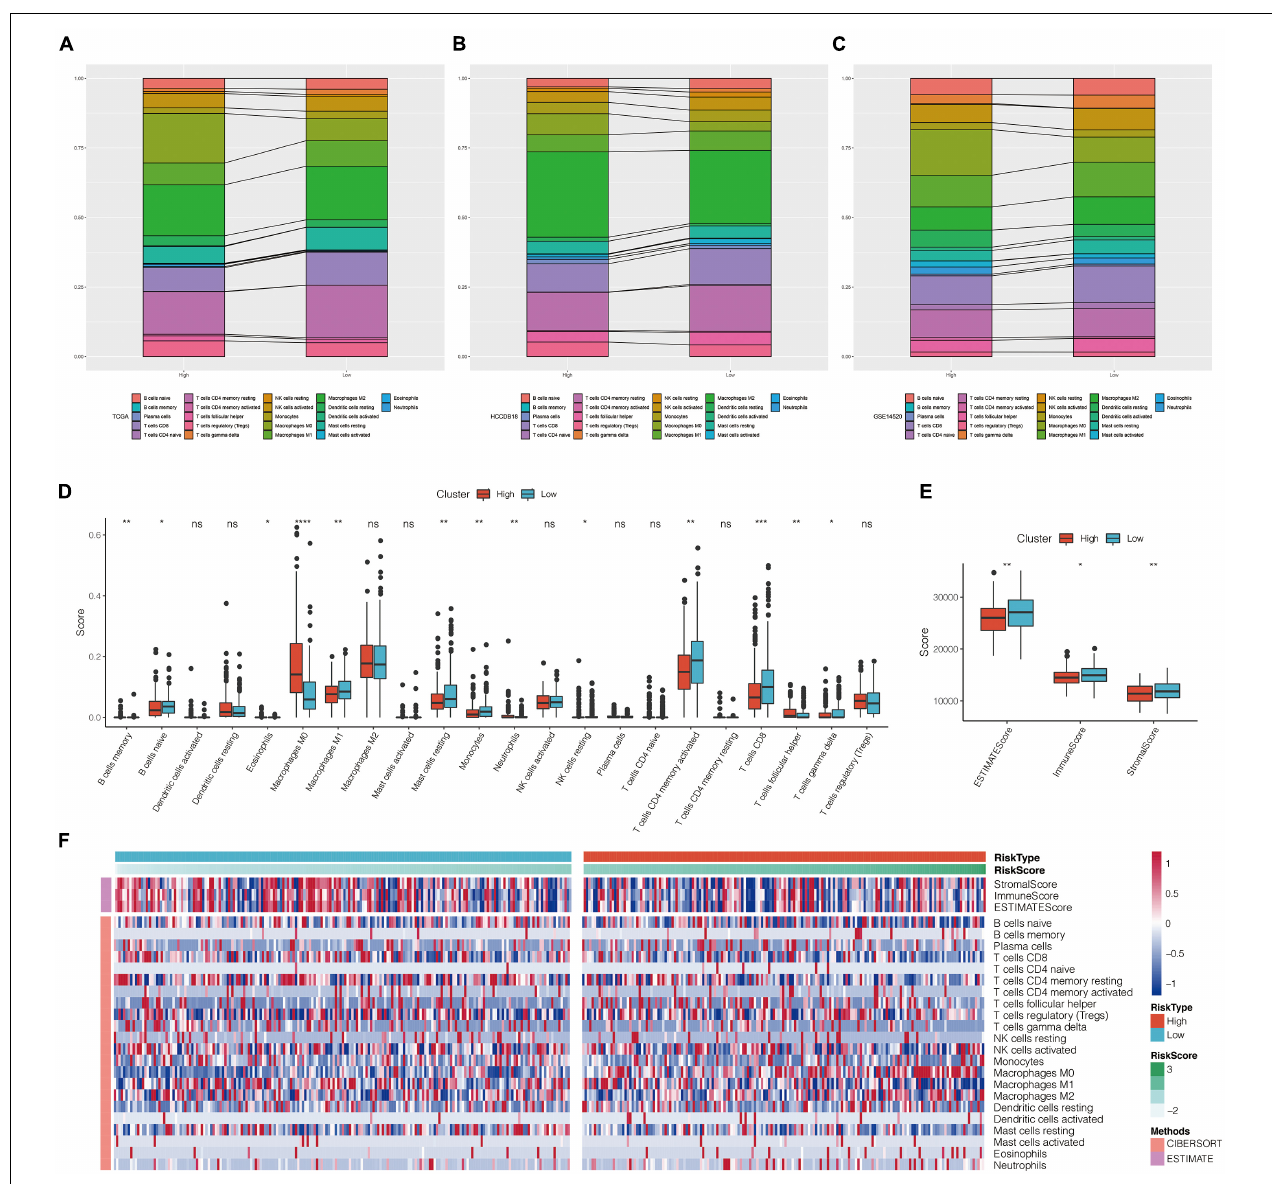
FIGURE 9 | (A–C) Landscape of immune cell infiltration score in high-risk and low-risk groups of TCGA, HCCDB18, and GSE14520 data sets. (D) Comparison of CIBERSORT immune score between high-risk and low-risk groups in TCGA data set. (E) Comparison of estimate immune score between high-risk and low-risk groups in TCGA data set. (F) Heat map of correlation between CIBERSORT immune score and estimate immune score in high-risk and low-risk groups. * P < 0.05, ** P < 0.01, *** P < 0.005, and **** P < 0.001; ns , no